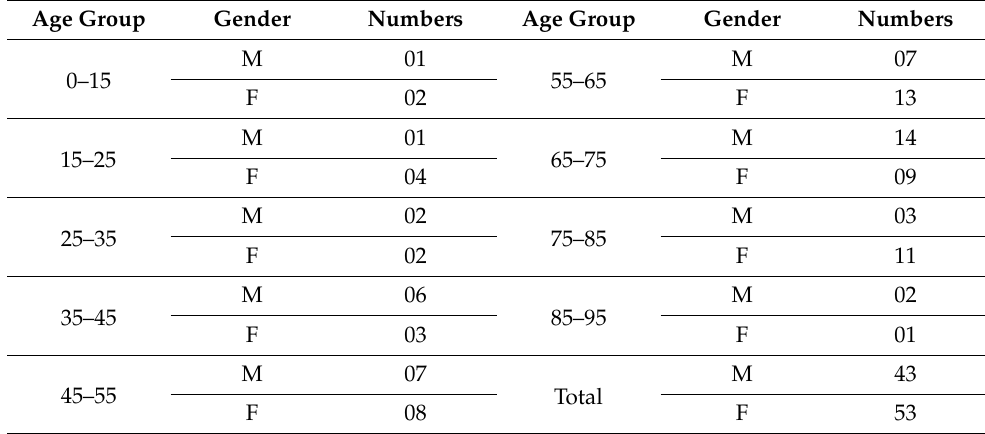
Table 1. Age Group and Gender Distribution of Patients having Syncope.